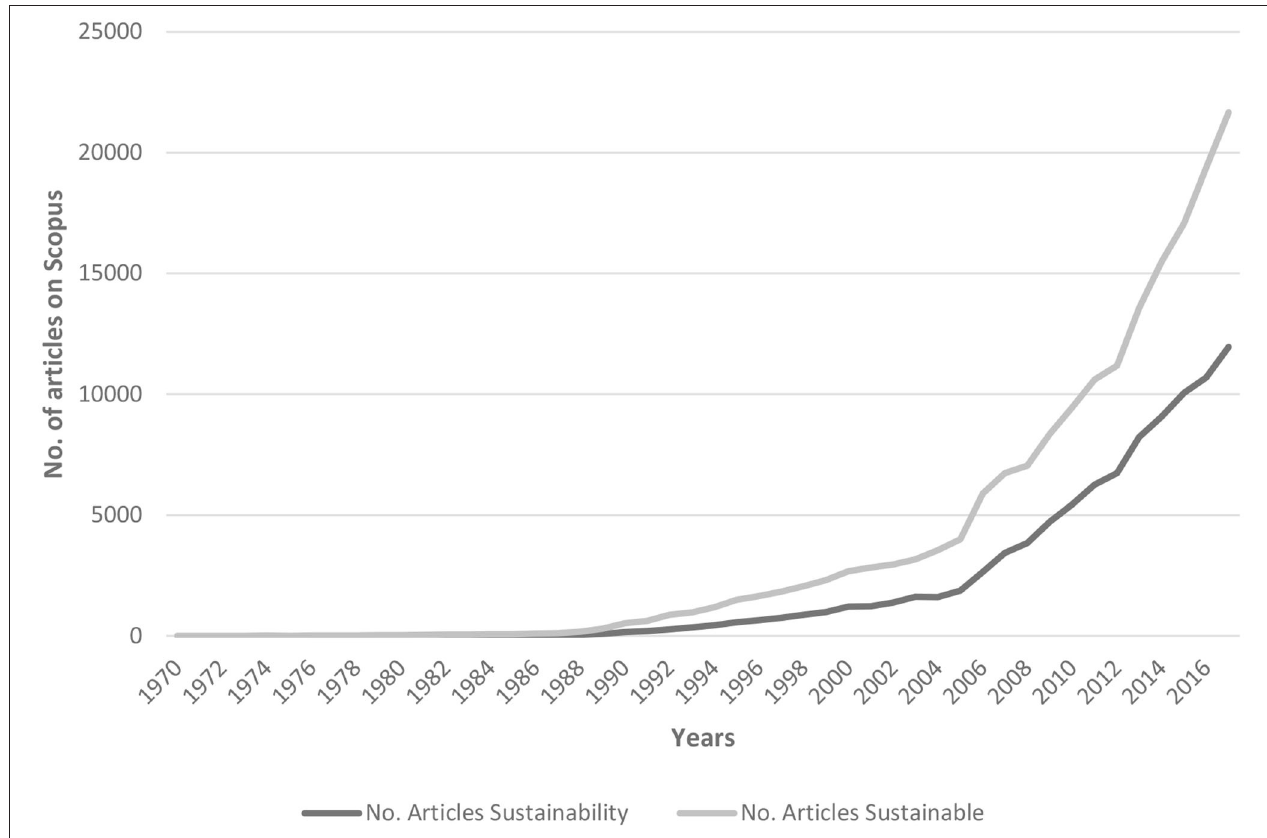
FIGURE 1 | The number of publications available on the academic database, SCOPUS (accessed May,